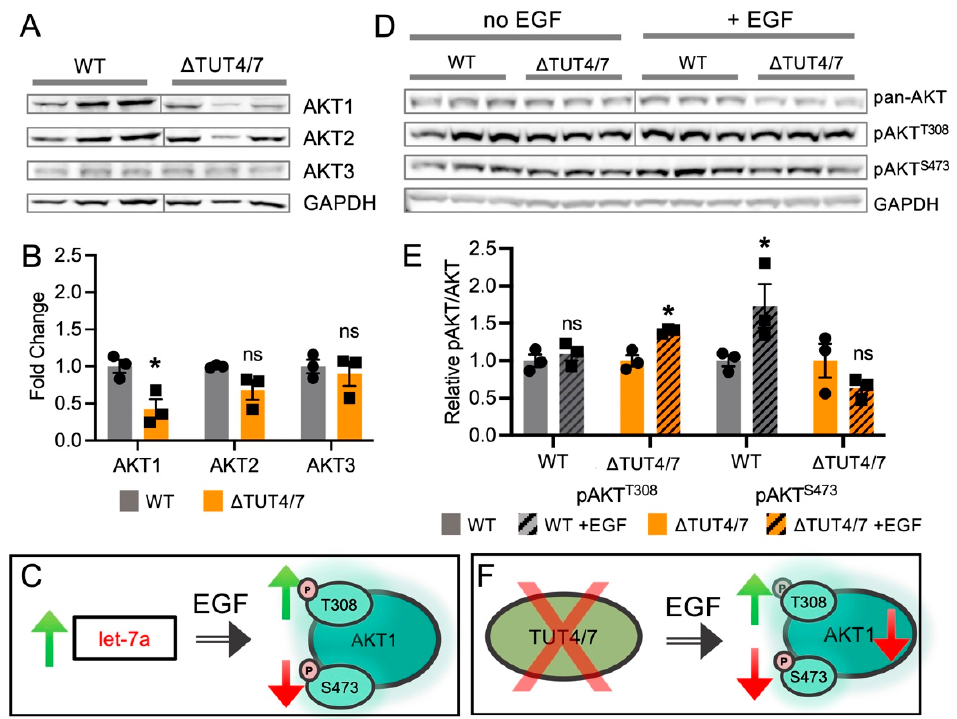
Figure 6. Messenger RNA and protein abundance are not directly related in the TUT4/7 deletion. ( A ) Western blots and ( B ) quantification of AKT isozymes in wild-type (black, circles) and Δ TUT4/7 (orange, squares) HEK 293T cells. ( C ) Artificial increase in let-7a levels by transfection was shown previously to increase T308 phosphorylation and reduce S473 phosphorylation of AKT1 in response to epidermal growth factor stimulation. ( D ) Western blots and ( E ) quantification of pan-AKT phosphorylation in wild-type (black, circles) and Δ TUT4/7 (orange, squares) HEK 293T cells. ( F ) Deletion of TUT4/7 alters response to EGF stimulation, increasing phosphorylation of AKT at T308 and reducing the response at S473. AKT1 specifically is decreased in Δ TUT4/7 cells. Blots were cropped to remove empty lanes ( A ) or molecular weight guides ( D ) for clarity. Asterisks indicate significance in Students t -test or ANOVA in GraphPad Prism where ns = not significant; * p < 0.05.